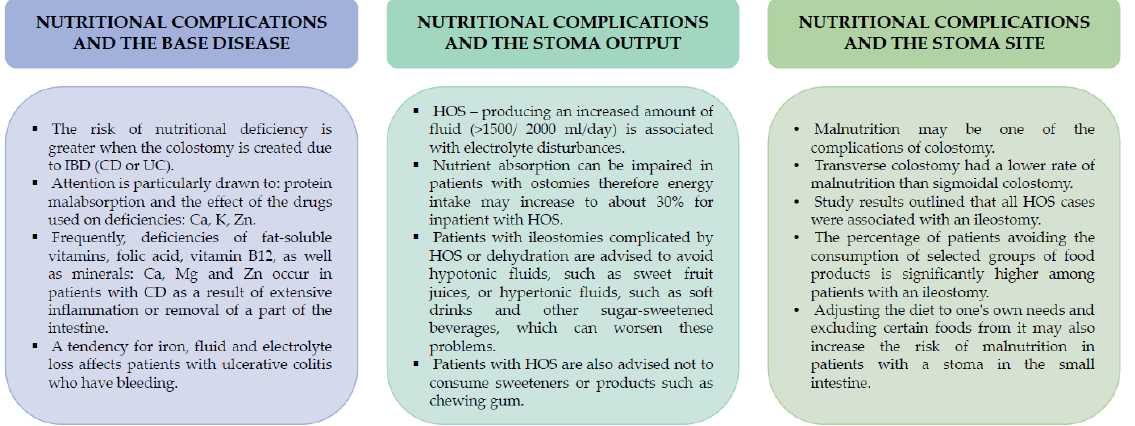
Figure 2. Key measures on the relationship between nutritional complications and stoma output, stoma cite and base disease.